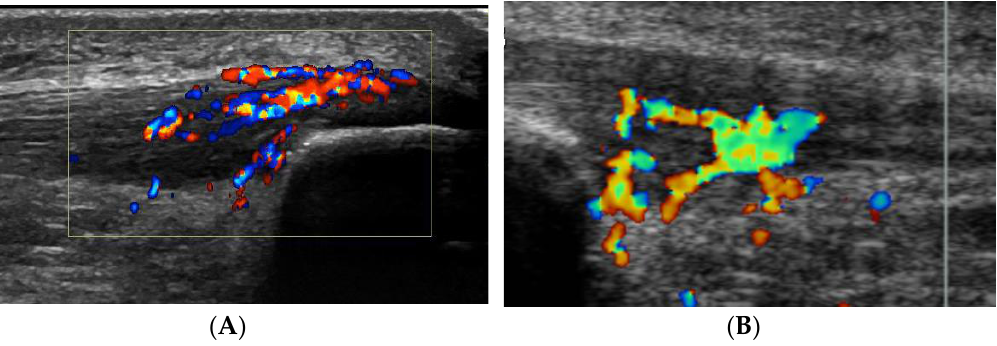
Figure 1. ( A , B ). Ultrasound and Doppler picture from 2 patients suffering from chronic painful patellar tendinopathy. There is a thickened proximal patellar tendon, including irregular tendon structure, hypo-echoic regions and high blood flow on the dorsal side of the tendon. ( A ): This patient also had severe tenderness on the superficial side of the proximal tendon, where there was a localized thickening of the paratenon including high blood flow. ( B ): This patient had no tenderness on the superficial side of the proximal tendon, where there was a normal paratenon and normal blood flow. All patients underwent deleted words ultrasound (US) and Doppler (DP)-guided arthroscopic shaving and also open superficial scraping deleted words (Figure 2) [6]. Tissue sections from the superficial peritendinous tissue of the patellar tendon were analyzed for morphology and innervation